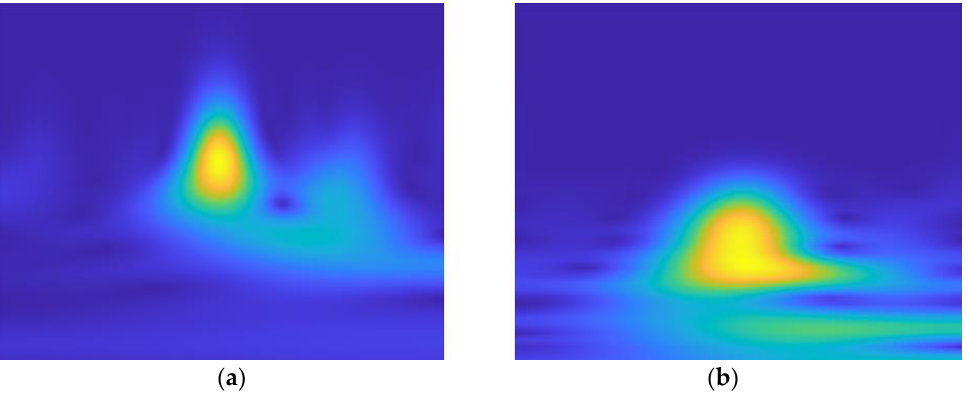
Figure 7. Morse wavelet according to T 2 . ( a ) T 2 = 10. ( b ) T 2 = 60.